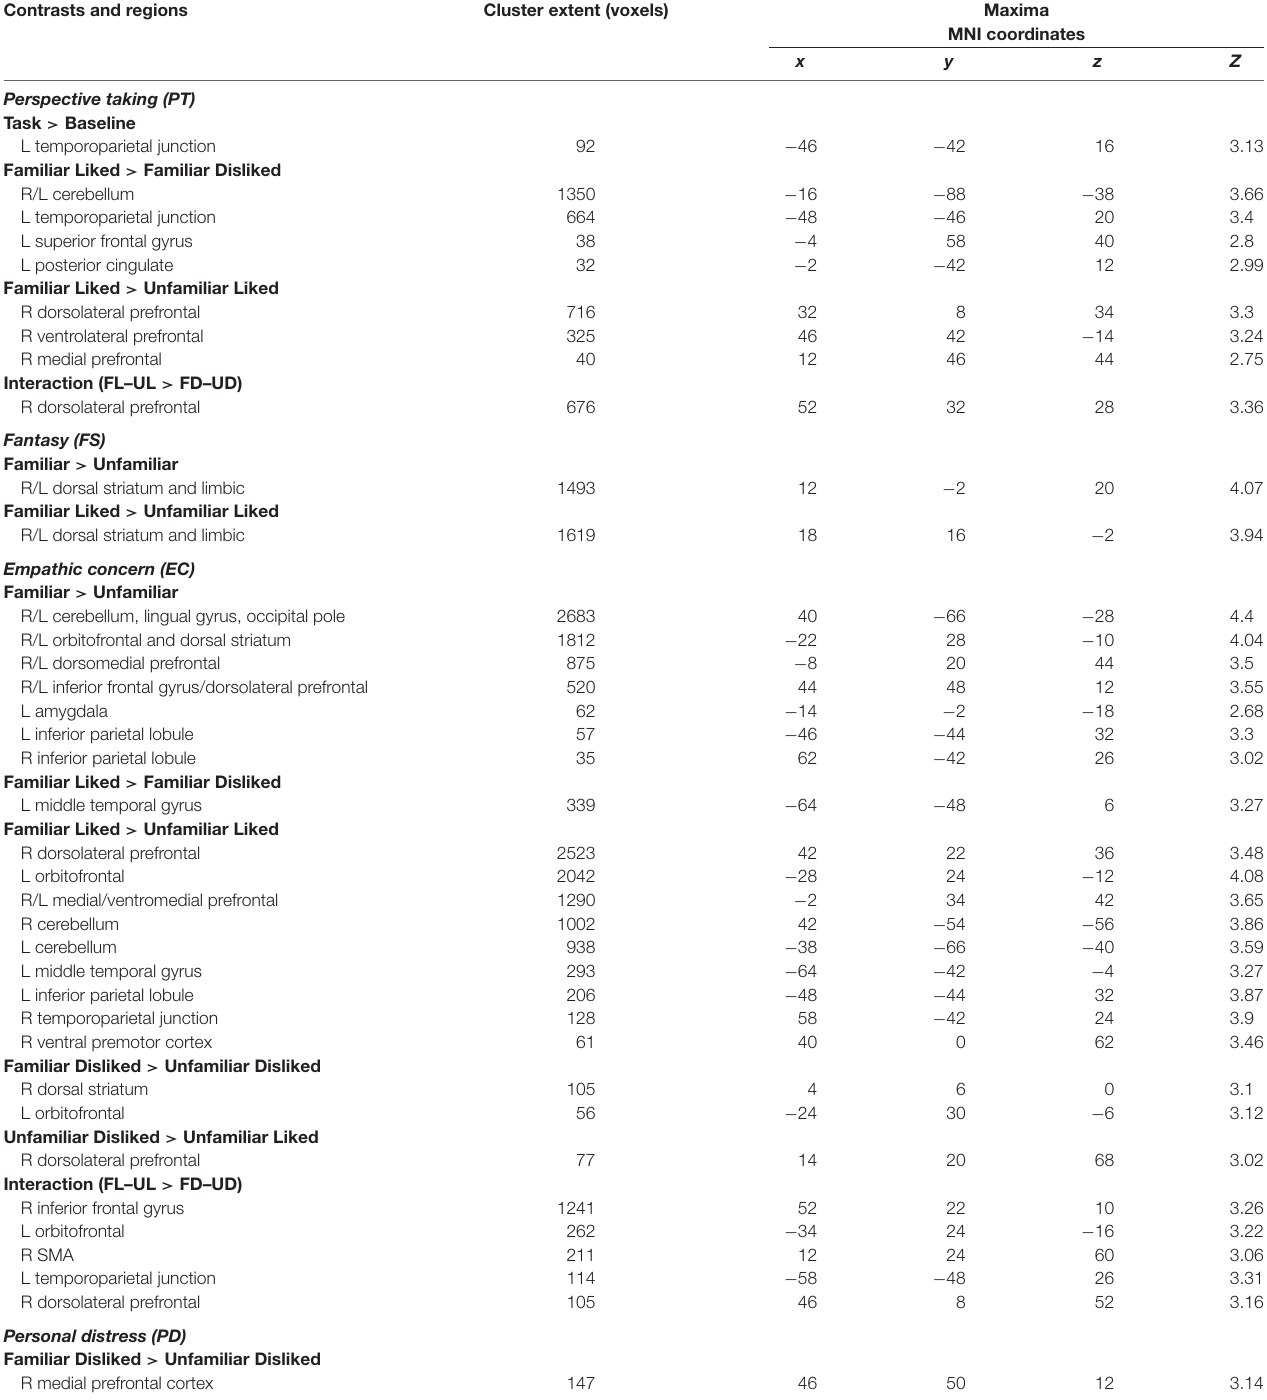
TABLE 2 | Experiment 2 results by IRI